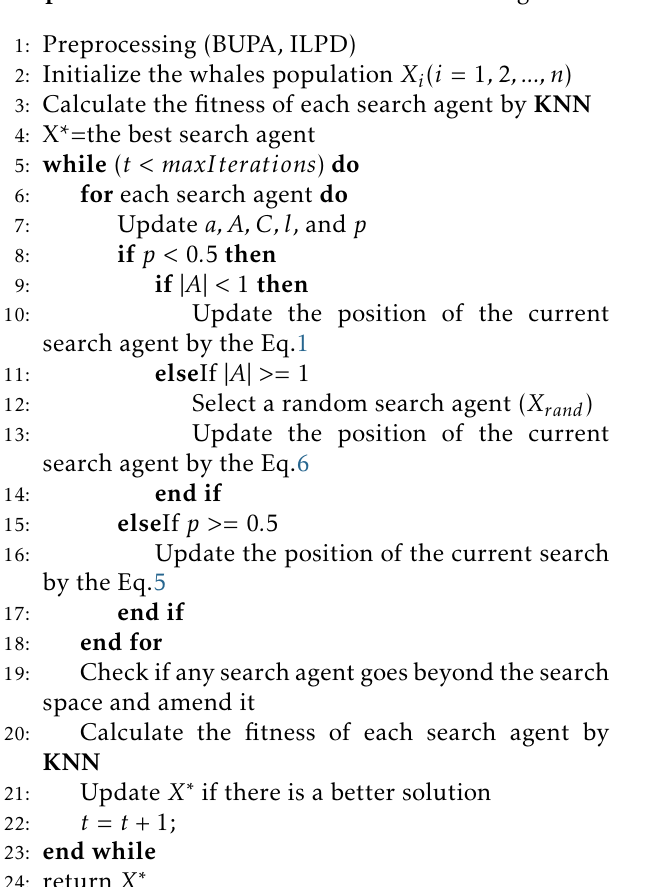
Table 4. The results obtained by WOA -KNN hybrid algorithm for BUPA Data set